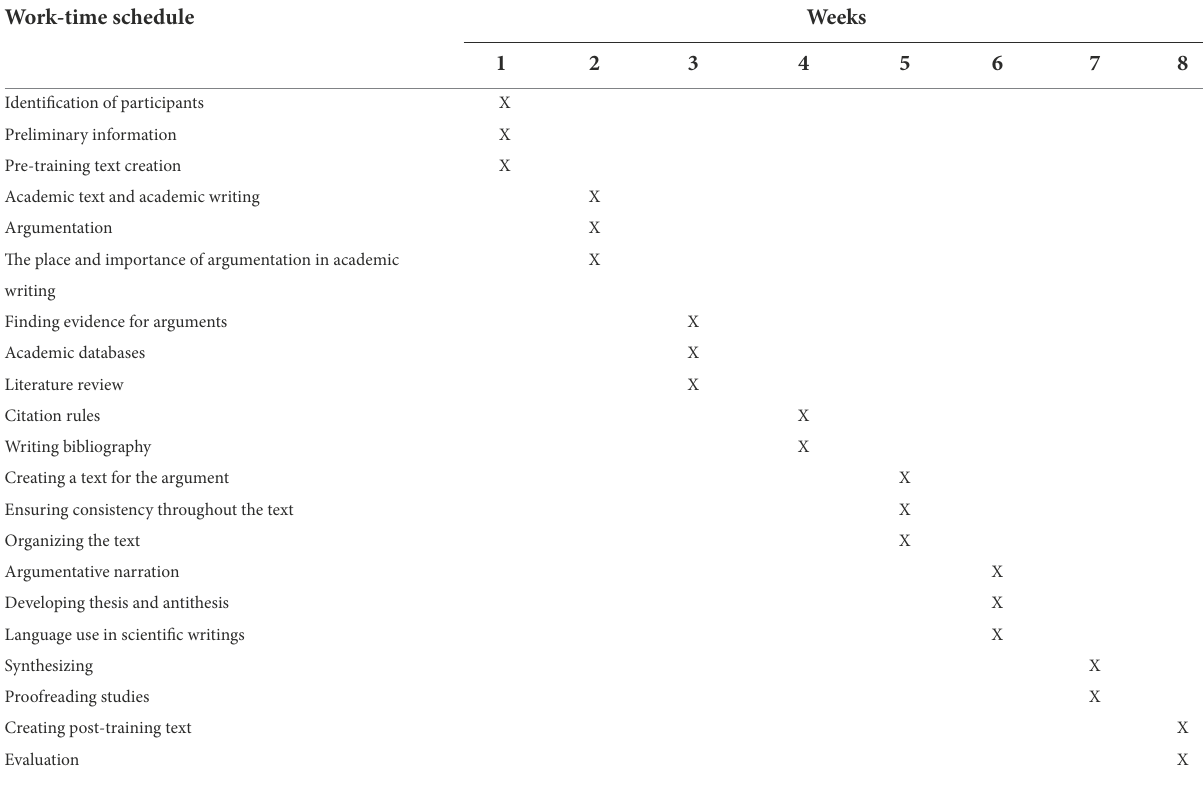
TABLE 2 Implementation process